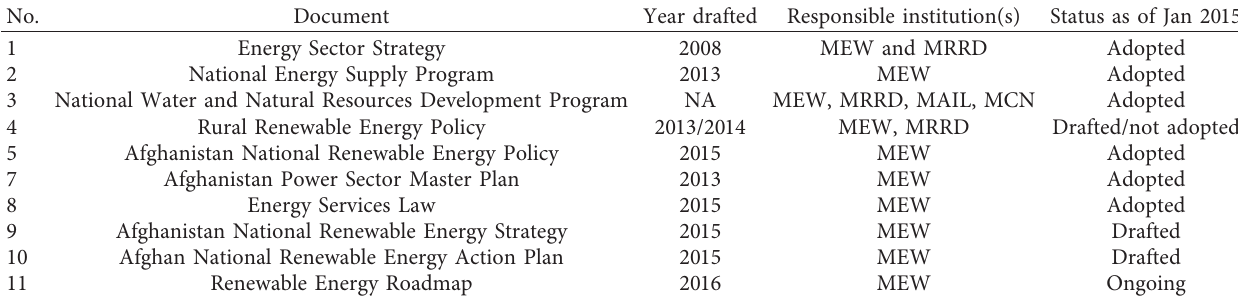
Table 3: Renewable energy development related documents in